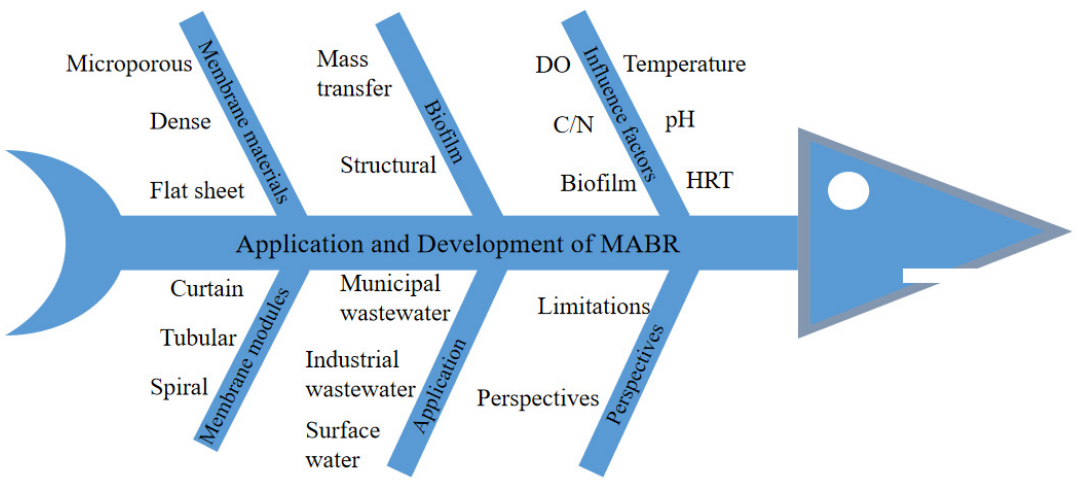
Figure 1. Application, development, influence factors, and perspectives of MABR.